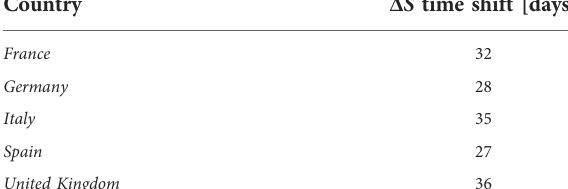
TABLE 5 Time shift for the alignment of the decreasing trends of the outbreak vs. the